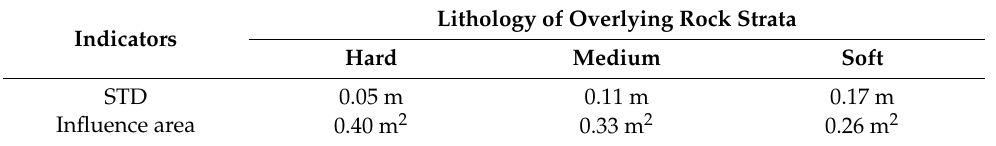
Figure 10. Examples of the errors of the NOV-estimated mining subsidence under hard ( q = 0.4 and tan β = 1.5), medium ( q = 0.7 and tan β = 2.2), and soft ( q = 0.9 and tan β = 2.9) overlying rock strata, respectively. In which, the ascending SAR imaging geometry was used (i.e., α = 350 ◦ and θ = 38 ◦ ). Hard is ( a ), medium is ( b ), soft is ( c ). Table 2. Standard deviations (STD) and the influence areas of the errors of the NOV-estimated mining subsidence under different overlying rock